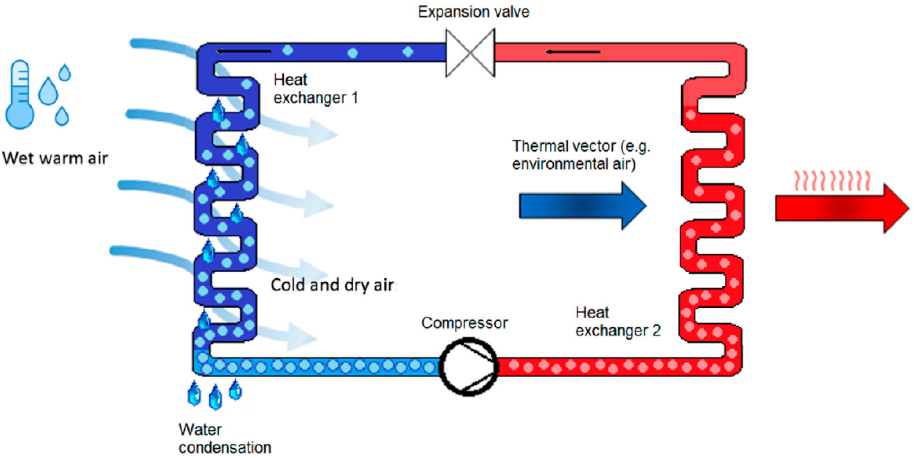
Figure 1. Atmospheric water generator [13] (under the terms of the Creative Commons Attribution License CC BY 4.0 license, https://creativecommons.org/licenses/by/4.0/ (accessed on 25 October 2021)).